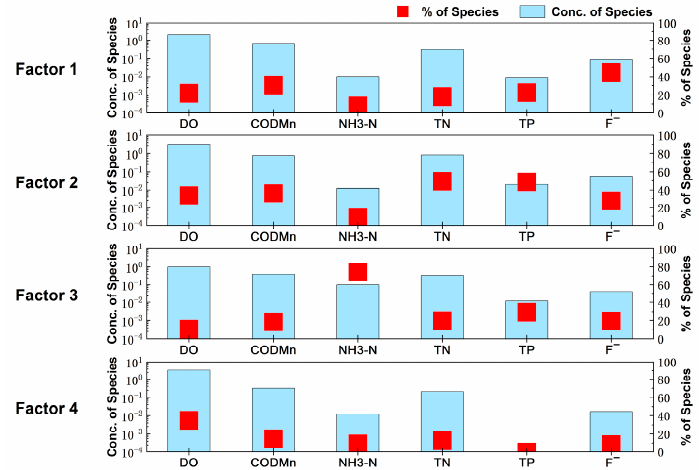
Figure 8. Source profile and contribution rate in the upstream.